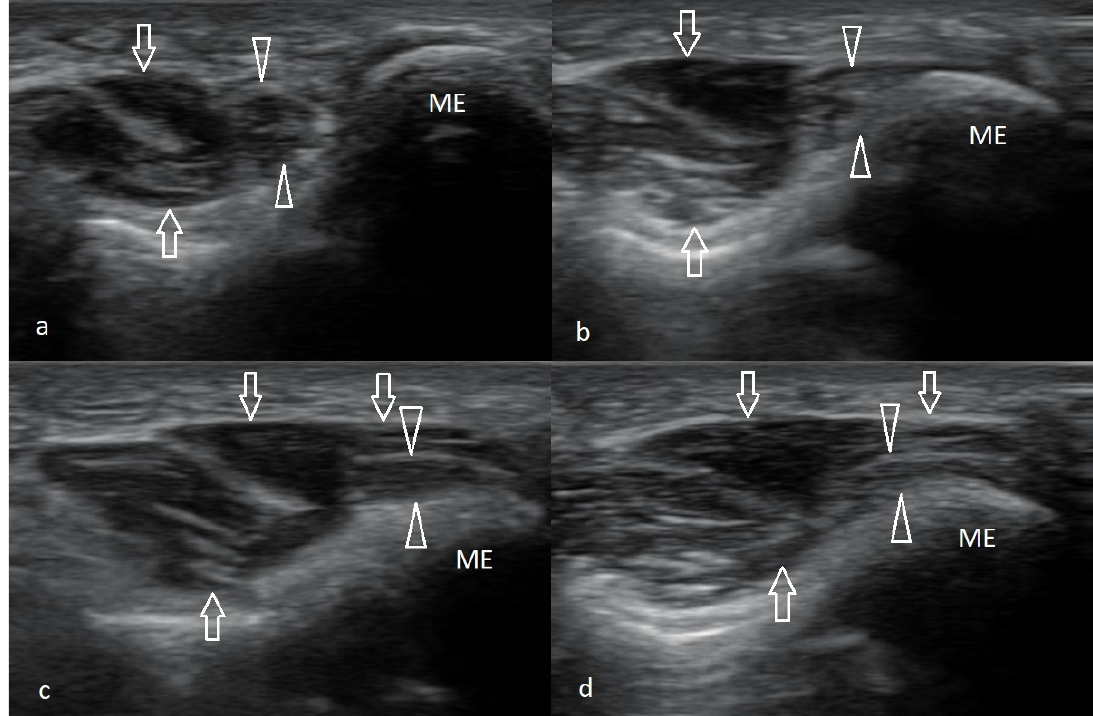
Figure 10. Snapping triceps syndrome. A series demonstrating the anterior dislocation of the medial head of triceps muscle over the surface of the medial epicondyle, which is accompanied by shifting the ulnar nerve beyond the sulcus and its compression; compression increases as the degree of flexion increases. ( a )—Examination in full extension, ( b )—90, ( c )—100, and ( d )—120 degrees of flexion; arrows—medial head of triceps muscle; arrowheads—ulnar nerve.